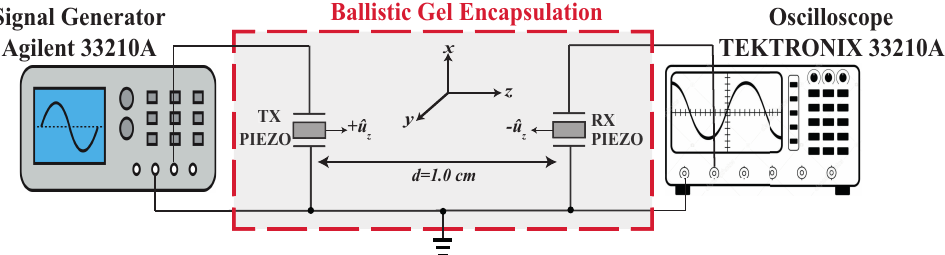
Figure 4. The experimental measurements setup used, including ballistic gel for the encapsulation of the two piezoelectric transducers.